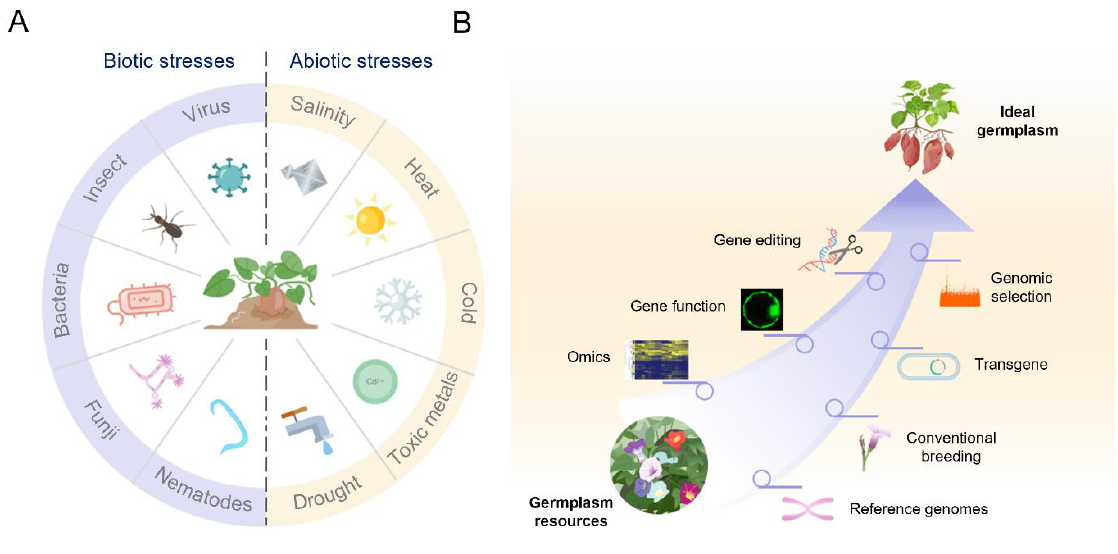
Figure 2. Proposed strategy for achieving sweet potato improvement. ( A ) Representation of biotic and abiotic stress factors that affect sweet potato production. ( B ) Harnessing the power of multi- approaches for genetic improvement in sweet potato. The use of traditional breeding and modern crop improvement tools, such as transgene, genomic selection, and gene editing, has made it possible to rapidly produce ideal germplasm.